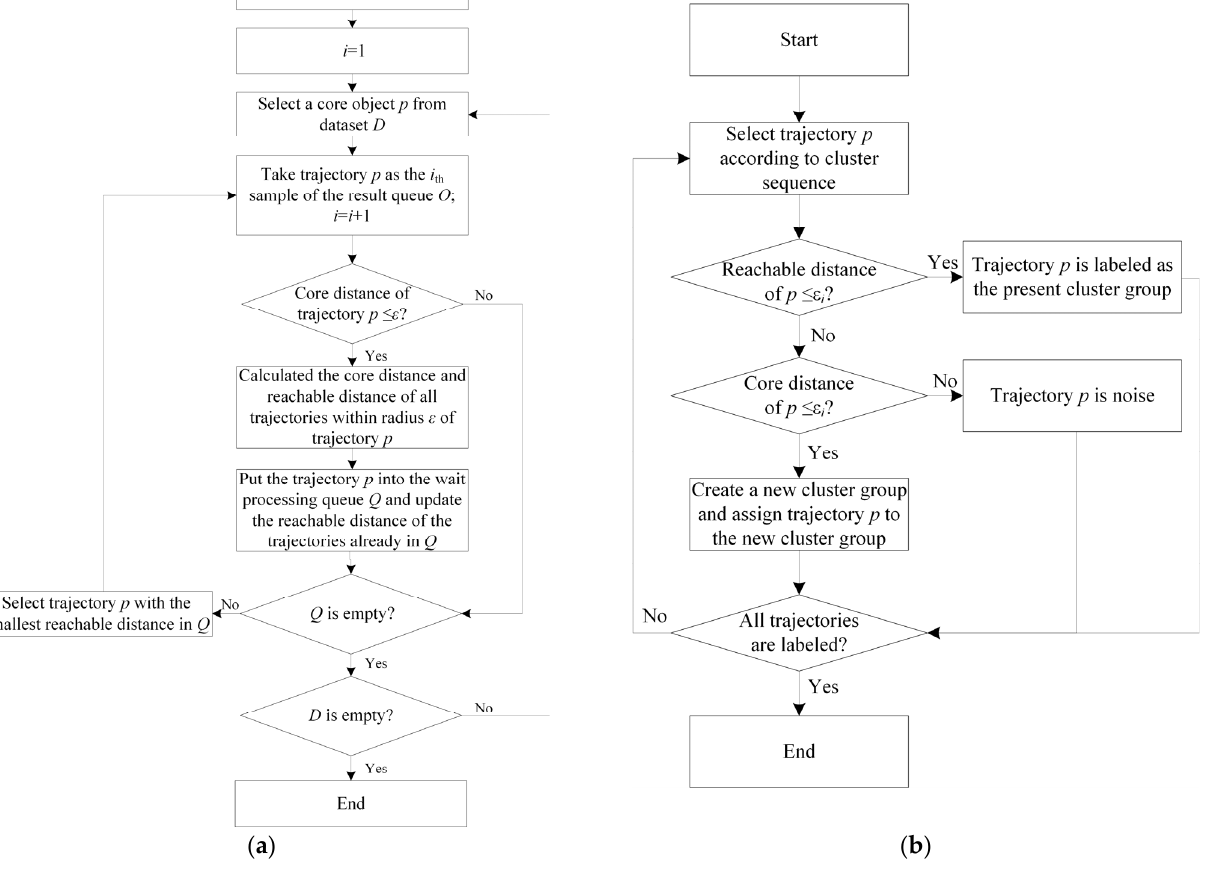
Figure 3. Trajectory clustering process based on the OPTICS algorithm. ( a ) Cluster sequence generation, ( b ) Clustering label acquisition.